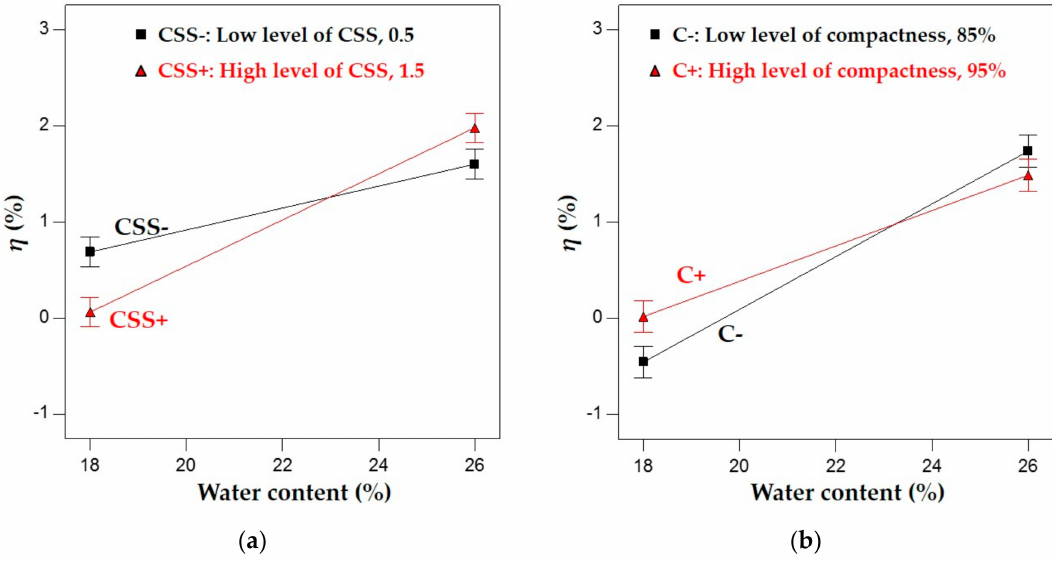
Figure 5. Interaction graphs of ( a ) soluble salt content (CSS) and water content ( b ) compactness and water